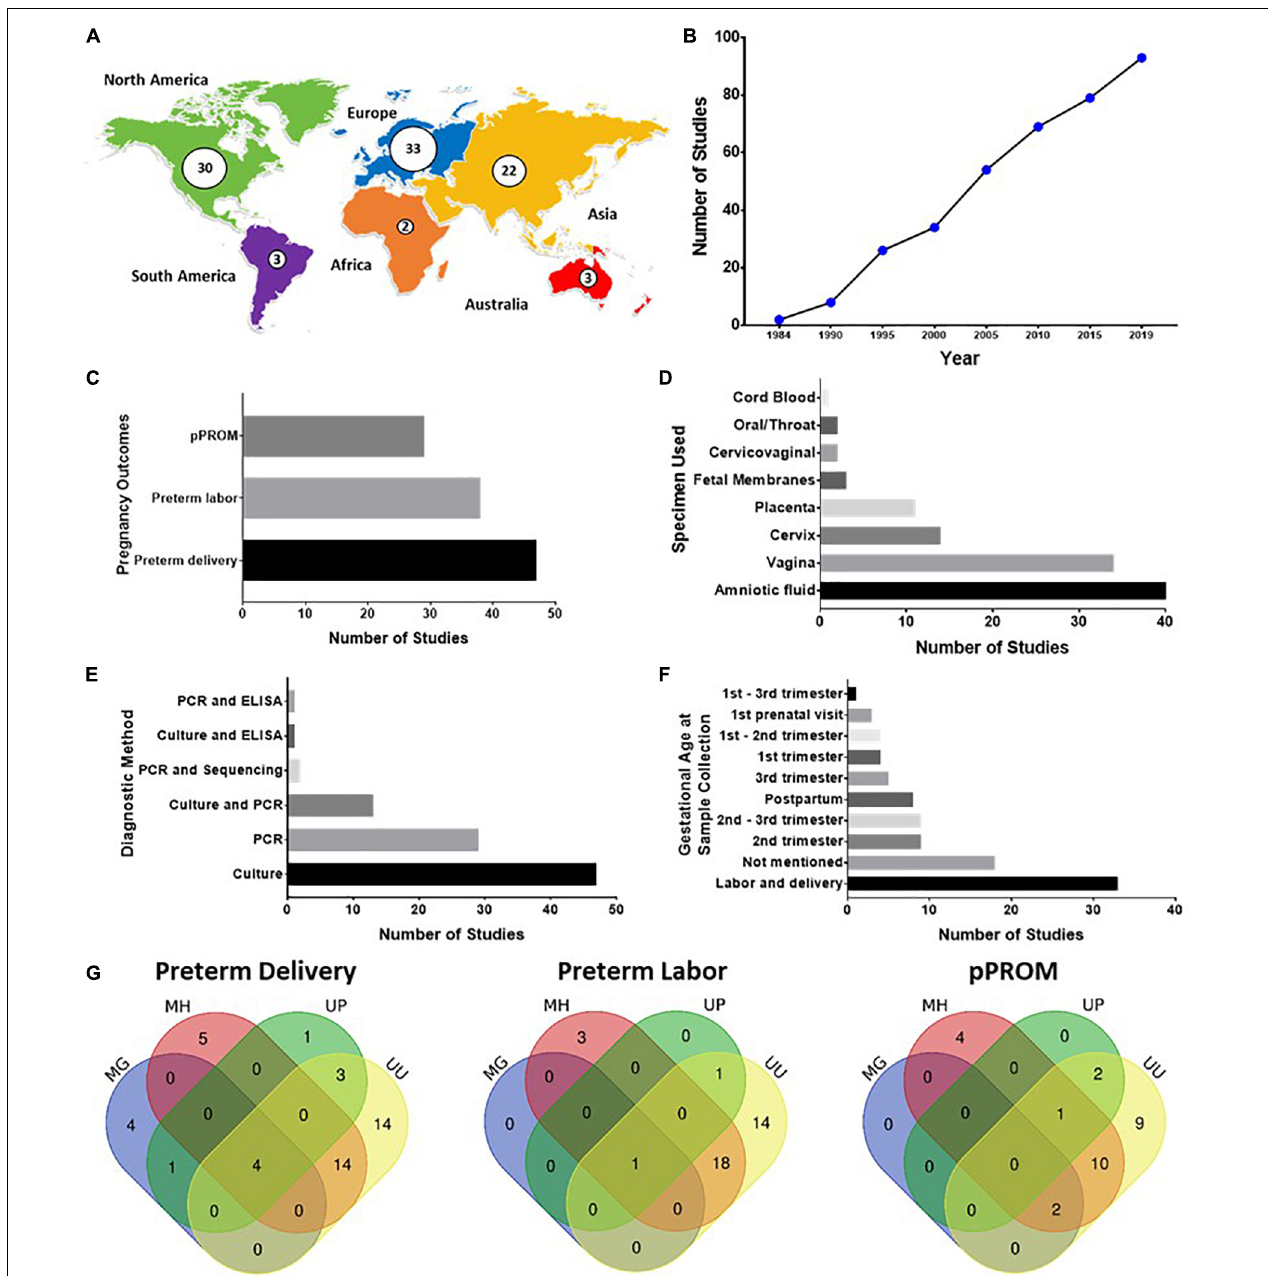
FIGURE 2 | (A–G) Summary of studies on the association of genital Mycoplasma infection with preterm birth. (A) Geographical distribution of published studies on genital Mycoplasma and preterm birth. (B) Cumulative count of published studies in genital Mycoplasma and preterm birth. (C) Types of pregnancy outcomes studied. (D) Samples used for diagnosing genital Mycoplasma infections (E) Diagnostic method used for detecting genital Mycoplasma infections (F) Gestational age of patients during the time of sample collection for diagnosing genital Mycoplasma infections. (G) Venn diagrams depicting the combination of different genital Mycoplasma species detected from patients with spontaneous preterm labor (SPTL), preterm birth (PTB), and preterm prelabor rupture of membranes